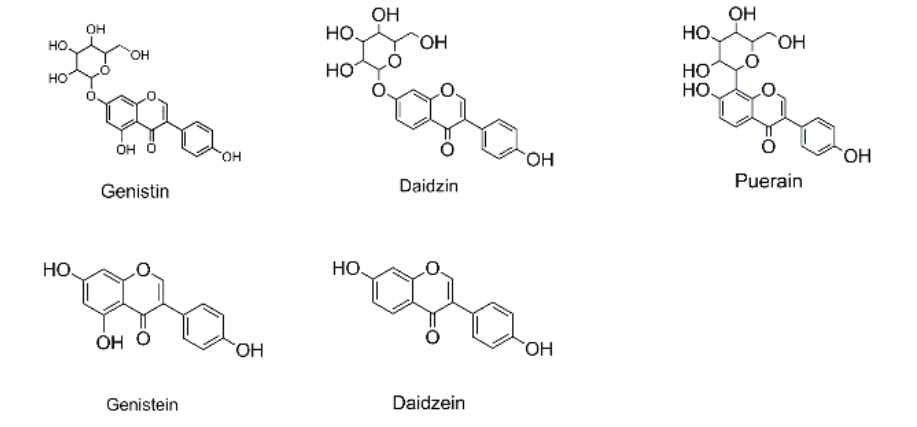
Figure 2. The chemical structures of the five reference standards.